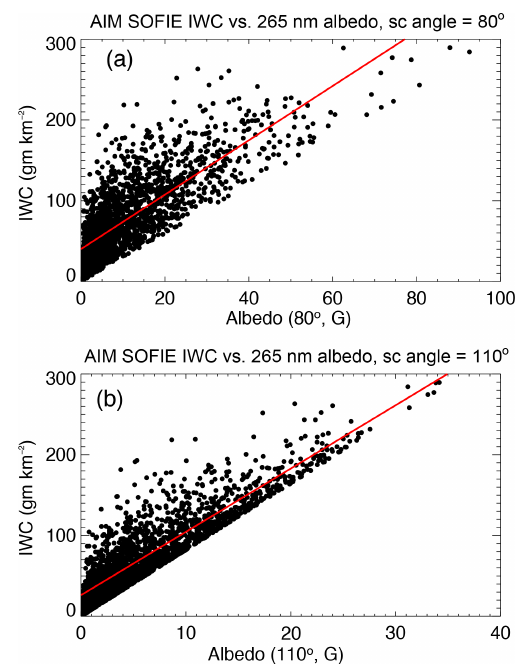
Figure 11. Examples of SOFIE AIR regressions for two (specified) scattering angles, (a) 80 ◦ and (b) 110 ◦ .